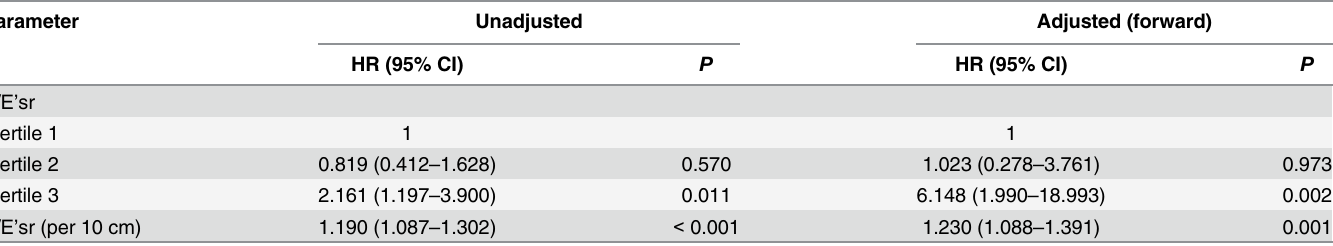
Table 3. Relation of E/E ’ sr tertiles and E/E ’ sr (continuous data) to progression to renal end point ( ≧ 25% decline in eGFR) using Cox proportional hazards model.